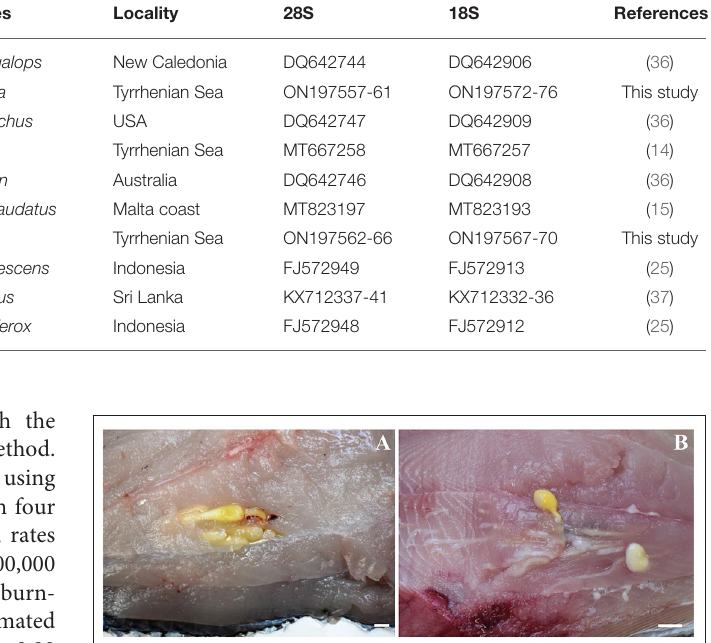
TABLE 1 | Species, life-history (L, larva; A, adult), host species, locality of collection, and GenBank accession numbers of 28S and 18S sequences of taxa of the family Gymnorhynchidae included in the phylogenetic analysis shown in Figure 5 . Species